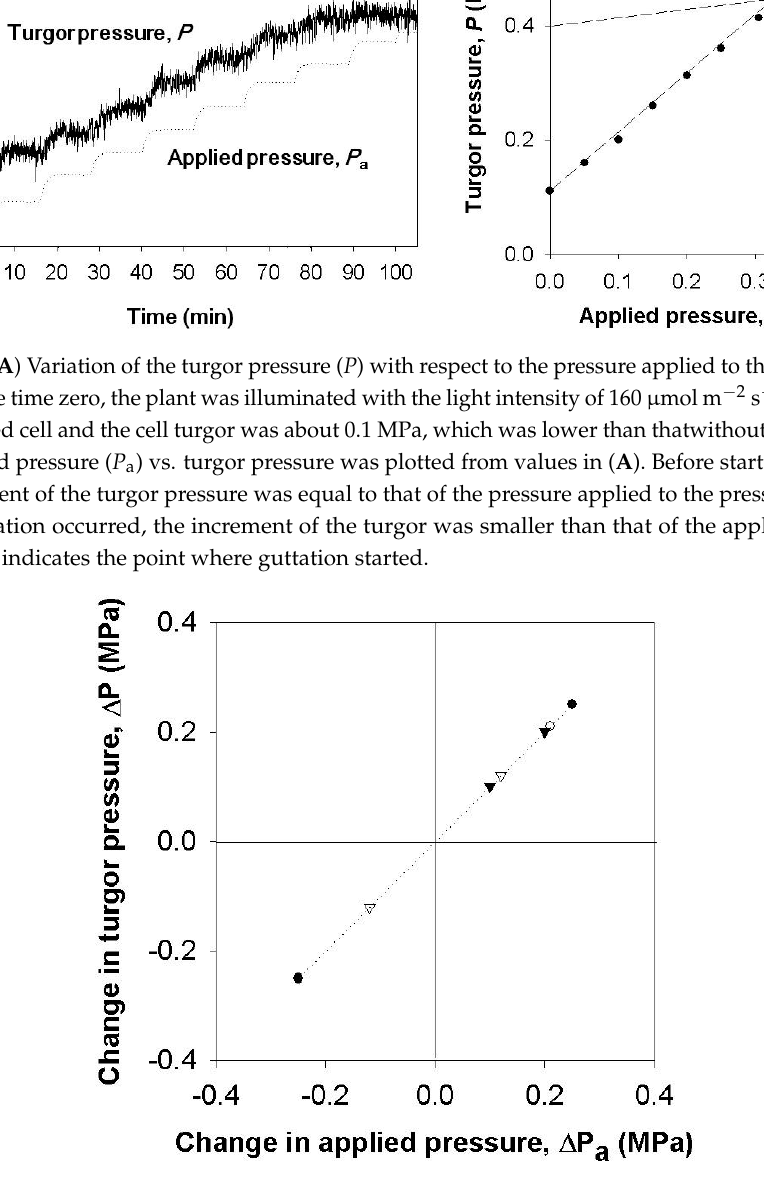
Figure 2. Change in the turgor pressure ( Δ P ) with respect to the changes in pressure applied to the root system ( Δ P a ). Different symbols indicate different cells and only cells with no guttation were included. The dotted line shows the 1:1 relationship in pressure changes.